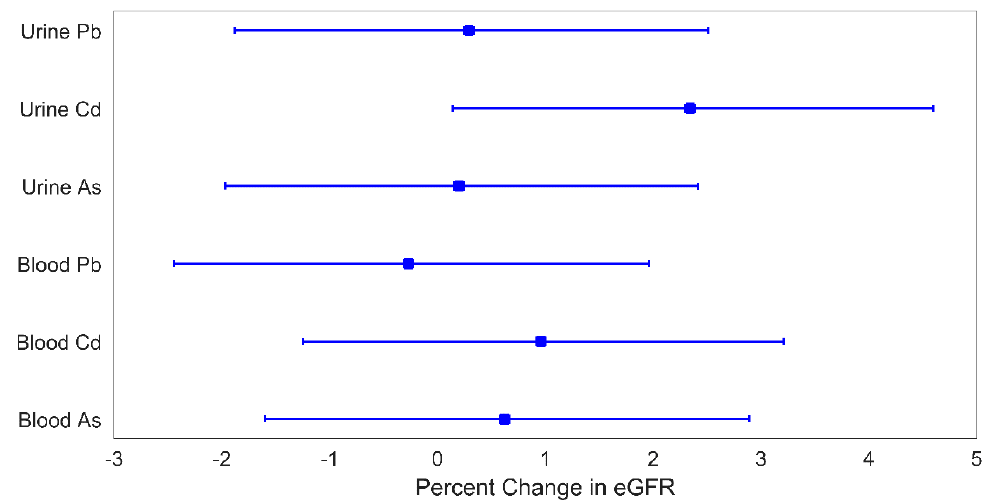
Figure 1. Percent change in eGFR for a 1-quartile increase in metal levels. Plotted points are beta coefficients and lines are 95% confidence intervals. All models were adjusted for child age (years), child sex, indoor tobacco smoke exposure (referent group: no), SES (referent group: lower), and BMI (referent group: BMI z-score < 1). The p-values for these associations are: 0.79 (urine Pb), 0.04 (urine Cd), 0.86 (urine As), 0.81 (blood Pb), 0.40 (blood Cd), and 0.59 (blood As).